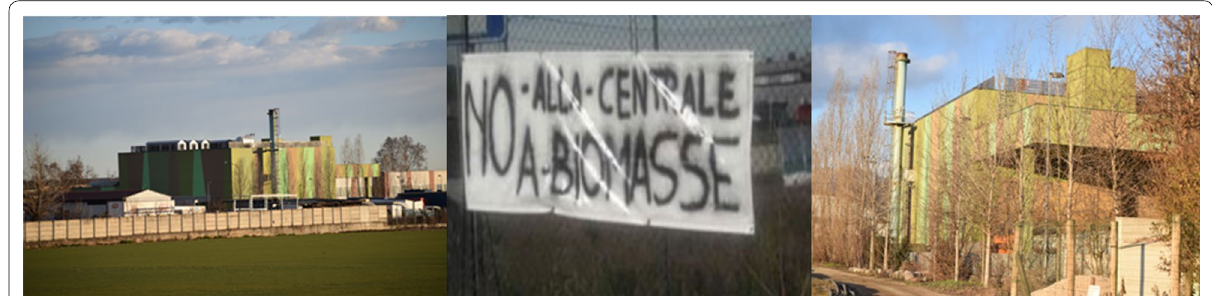
Fig. 6 Failure to comply with procedural equity. The involvement of the population deficiencies for the central biomass plant in Rodengo Saiano (BS) have meant that it was forming a spontaneous protest committee: The opening of the center, in advance of the plan has sparked the ire of the committee “No Central Biomass “accusing the company of not having waited for the results of the checks made by ARPA on the air (Source: http:// www.quibr escia